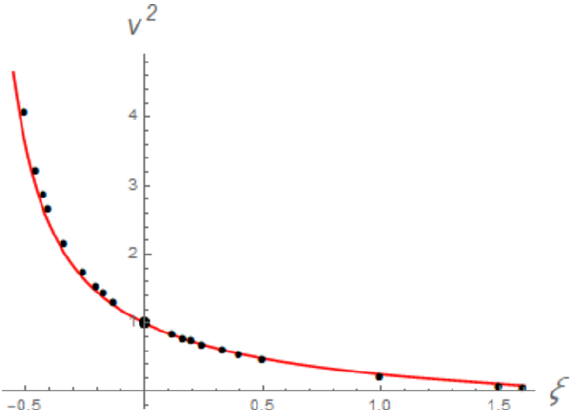
Figure 4 . Relation between the near-horizon parameter (cid:24) and the squashing v 2 of the boundary metric, for (cid:11) = 0 : 82. v 2 is positive and (cid:12)nite for (cid:0) 0 : 7 . (cid:24) . 1 : 6. The black dots represent the values e(cid:11)ectively calculated by means of the numerical analysis. The larger dot at ( (cid:24) = 0 ; v = 1) represents the solution of [12].